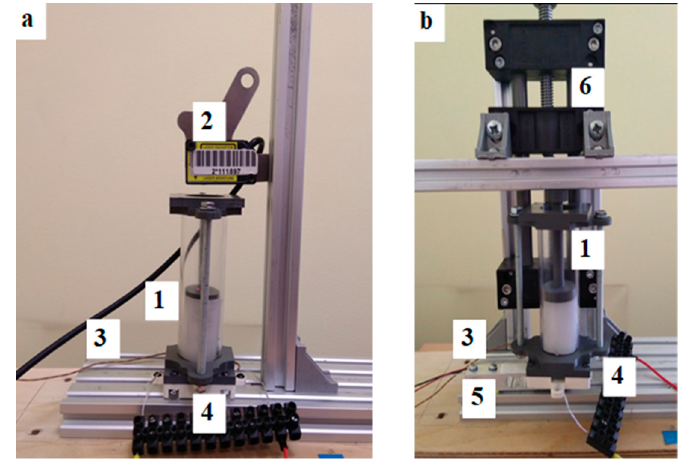
Figure 4. Test stand for measuring the displacement of the tube actuators ( a ) and the blocking force ( b ) for tube actuators: 1—actuator, 2—laser distance sensor, 3—thermocouple outputs, 4—connection of power supply, 5—tensometric beam, 6—blocking beam sliding mechanism.